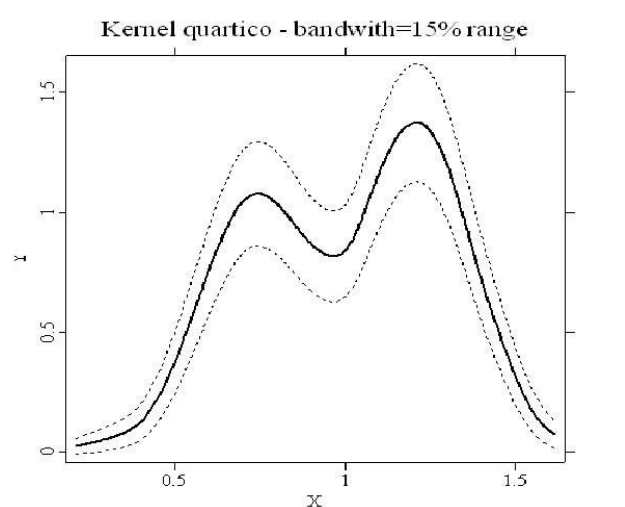
Figura 4 – Distribuzione condizionata alla struttura geospaziale